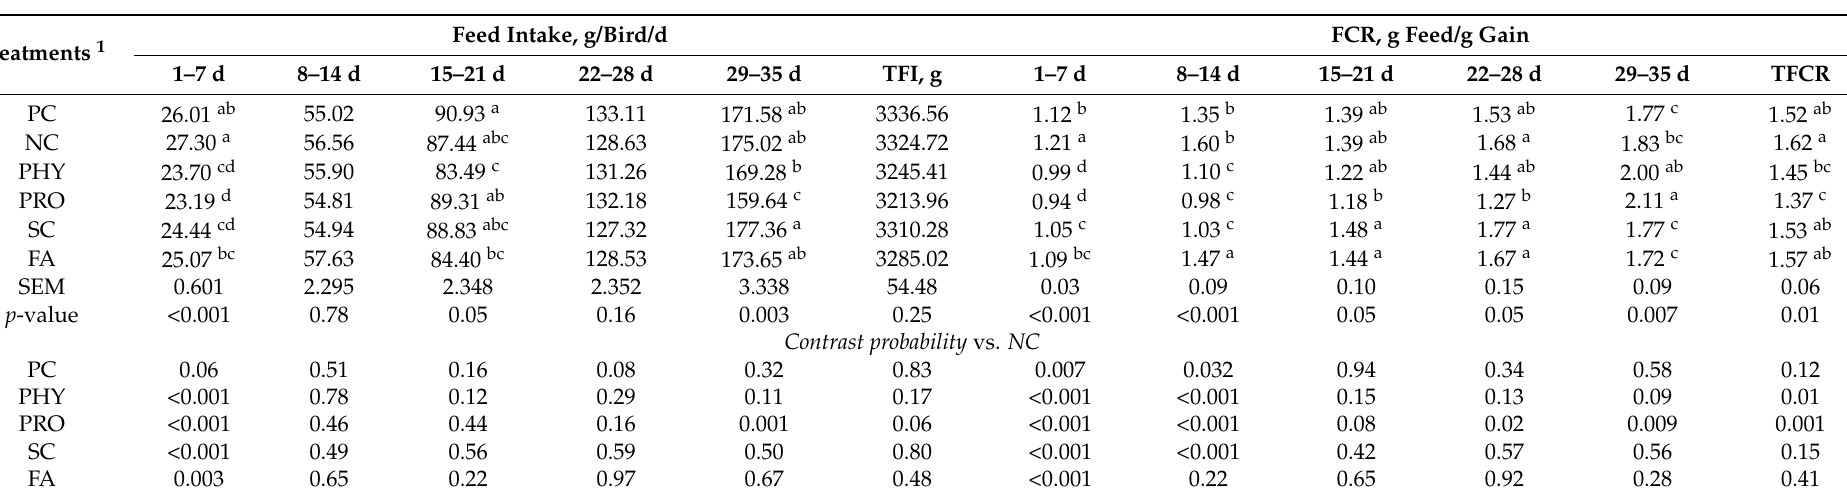
Table 3. Feed intake and feed conversion ratio (FCR) of broiler chickens fed a reduced nPP diet supplemented with phytase, probiotic, Saccharomyces cerevisiae , and fumaric acid during the